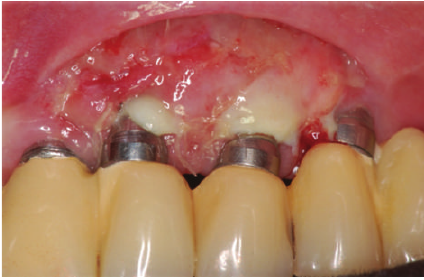
Figure 7: Postoperative aspect 90 days after surgery: indication for subepithelial connective tissue graft.